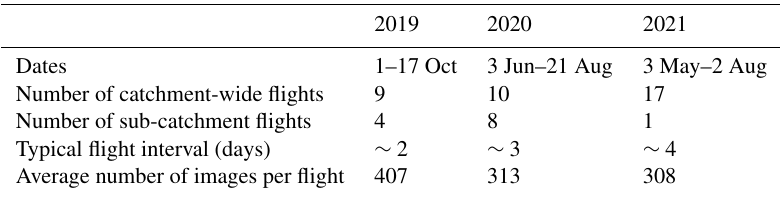
Figure 1. Overview of Illgraben’s upper catchment area, where high erosion on lateral slopes deposits material in the torrent channel (brown line), which mobilizes to debris flows. The yellow line denotes the UAV flight path. The blue line represents the Rhône River, and the map inset indicates Illgraben’s location within Switzerland (purple dot). The photograph inset shows the hexacopter Meteodrone MM-670 with a size of 96cm measured between two most distant propeller tips. Red symbols depict buildings. (b, c) UAV base with open (c) and closed (b) lid. The hexacopter used for acquiring the airborne imagery is visible in panel (c) , at the center of the takeoff and landing area. Hillshade in panel (a) from Swiss Federal Office of Topography swisstopo. Table 1. Autonomous UAV operation at Illgraben for the years 2019, 2020, and